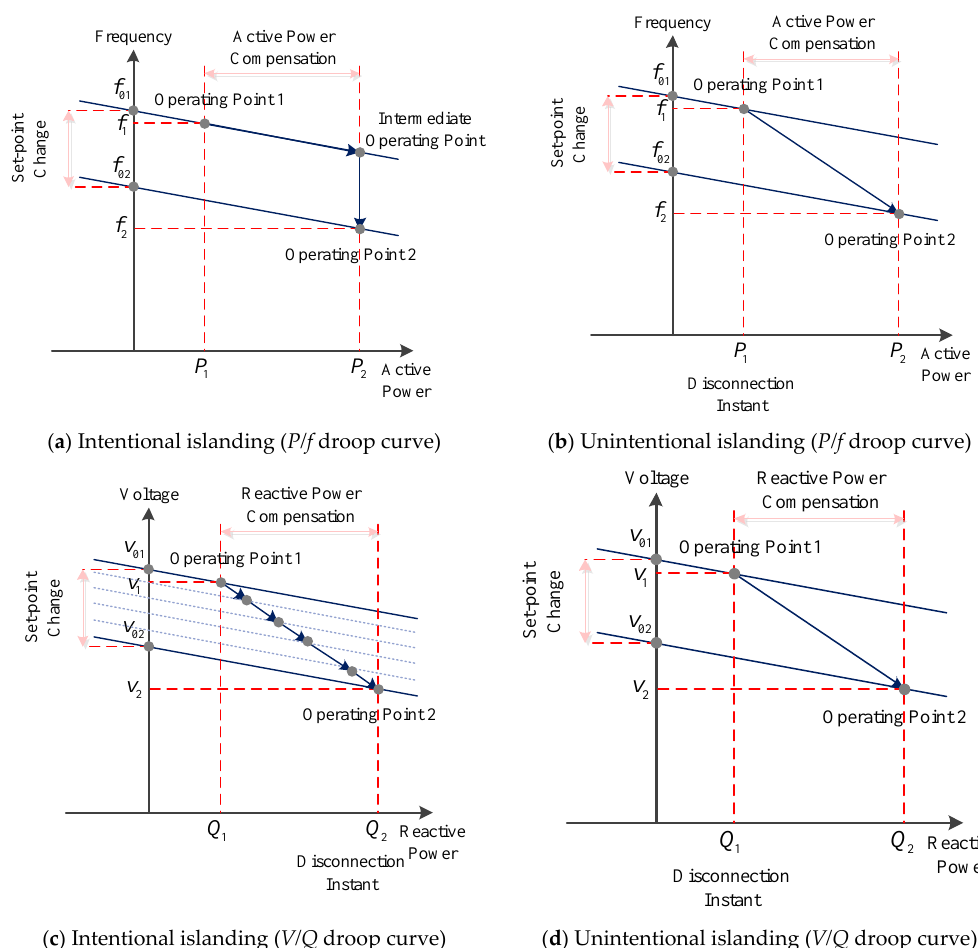
Figure 7. Droop curves during the disconnection instant.